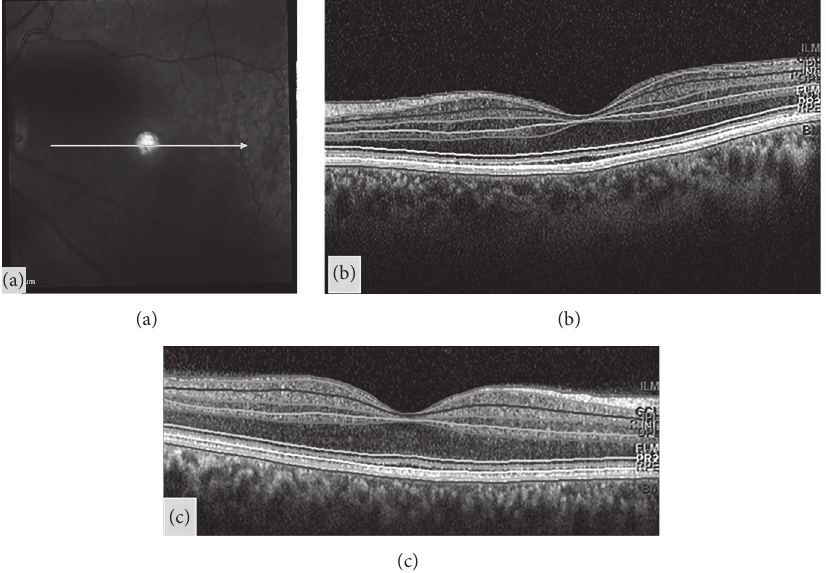
Figure 3: Example of segmentation analysis of the different retinal layers, in a cross-sectional linear scan of the macular area (a), obtained with Spectralis optical coherence tomography, in a healthy control (b) and a patient diagnosed with Parkinson disease (c). The marked lines are automatically provided by the segmentation software and represent the different layers of the retina. Corresponding acronyms are also provided by the segmentation software: ILM: inner limiting membrane; GCL: ganglion cell layer; IPL: inner plexiform layer; INL: inner nuclear layer; OPL: outer plexiform layer; ONL: outer nuclear layer; ELM: external limiting membrane; PR: photoreceptors; MB: Bruch’s membrane.